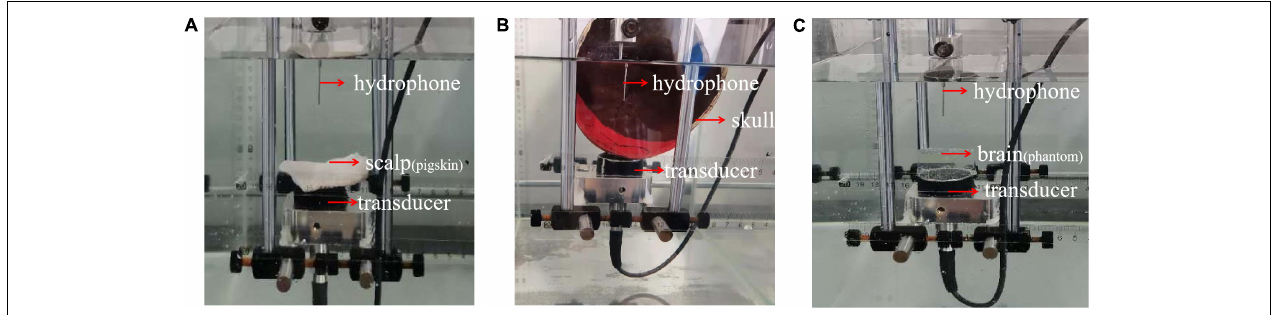
FIGURE 5 | Phantom experimental photograph of different head tissues. (A) Pigskin, (B) skull, and (C) tissue phantom are placed on ultrasound transducer, respectively, and the peak sound pressure is measured by a hydrophone.